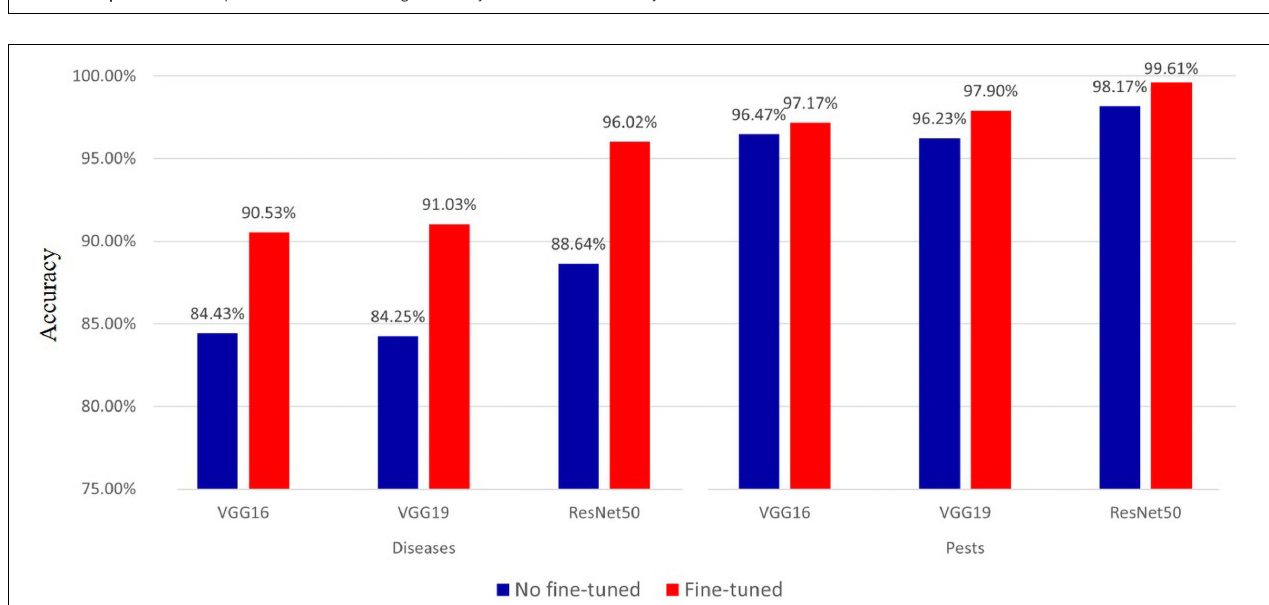
FIGURE 7 | Precision comparison when fine-tuning dense layer and conv + dense layer.